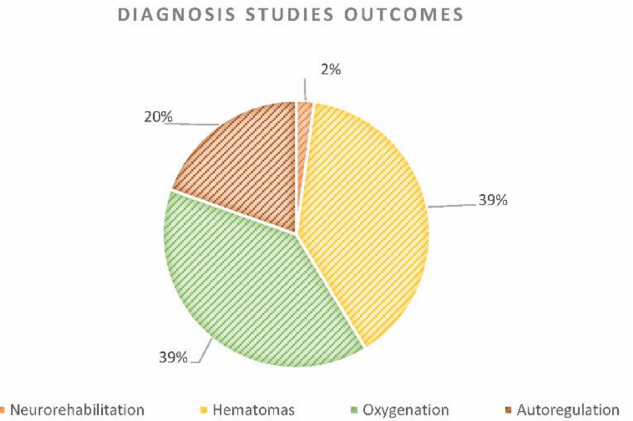
Figure 4. Percentage of diagnosis papers per subgroup according to the outcome measured: oxygenation, autoregulation, hematomas, and neurorehabilitation